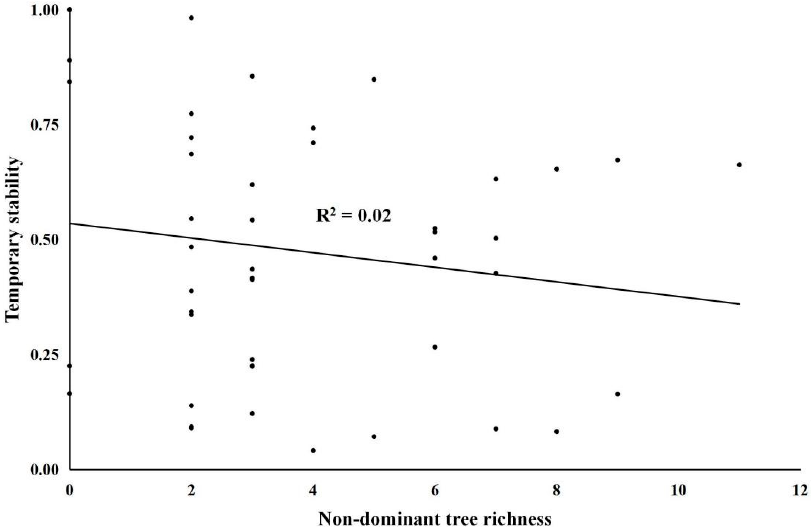
Figure 4. Scatter diagram between temporary stability (TS) and non-dominant tree richness